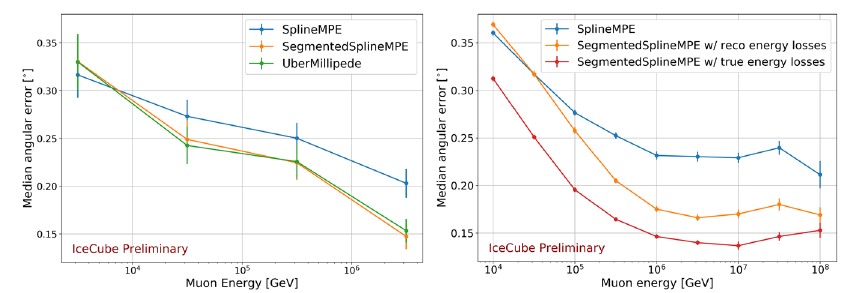
Figure 1. Median angular resolution for IceCube (left) and IceCube-Gen2 (right) all-sky simulations. For IceCube, the SegmentedSplineMPE reconstruction is compared to SplineMPE and to UberMilli- pede . For IceCube-Gen2, the SegmentedSplineMPE result seeded with true energy losses is also shown. The statistical error on the medians are calculated using bootstrapping